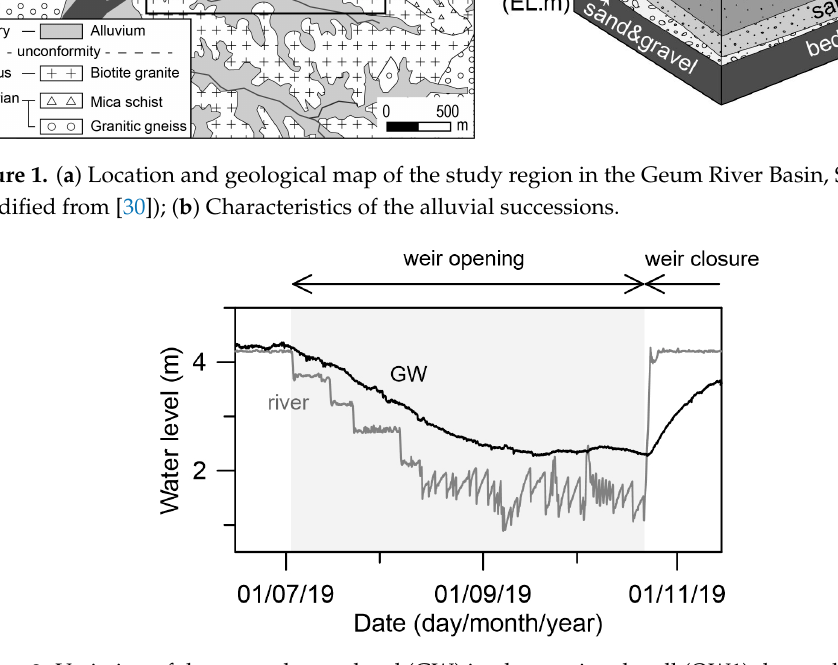
Figure 2. Variation of the groundwater level (GW) in observational well (OW1) due to the change in river level.